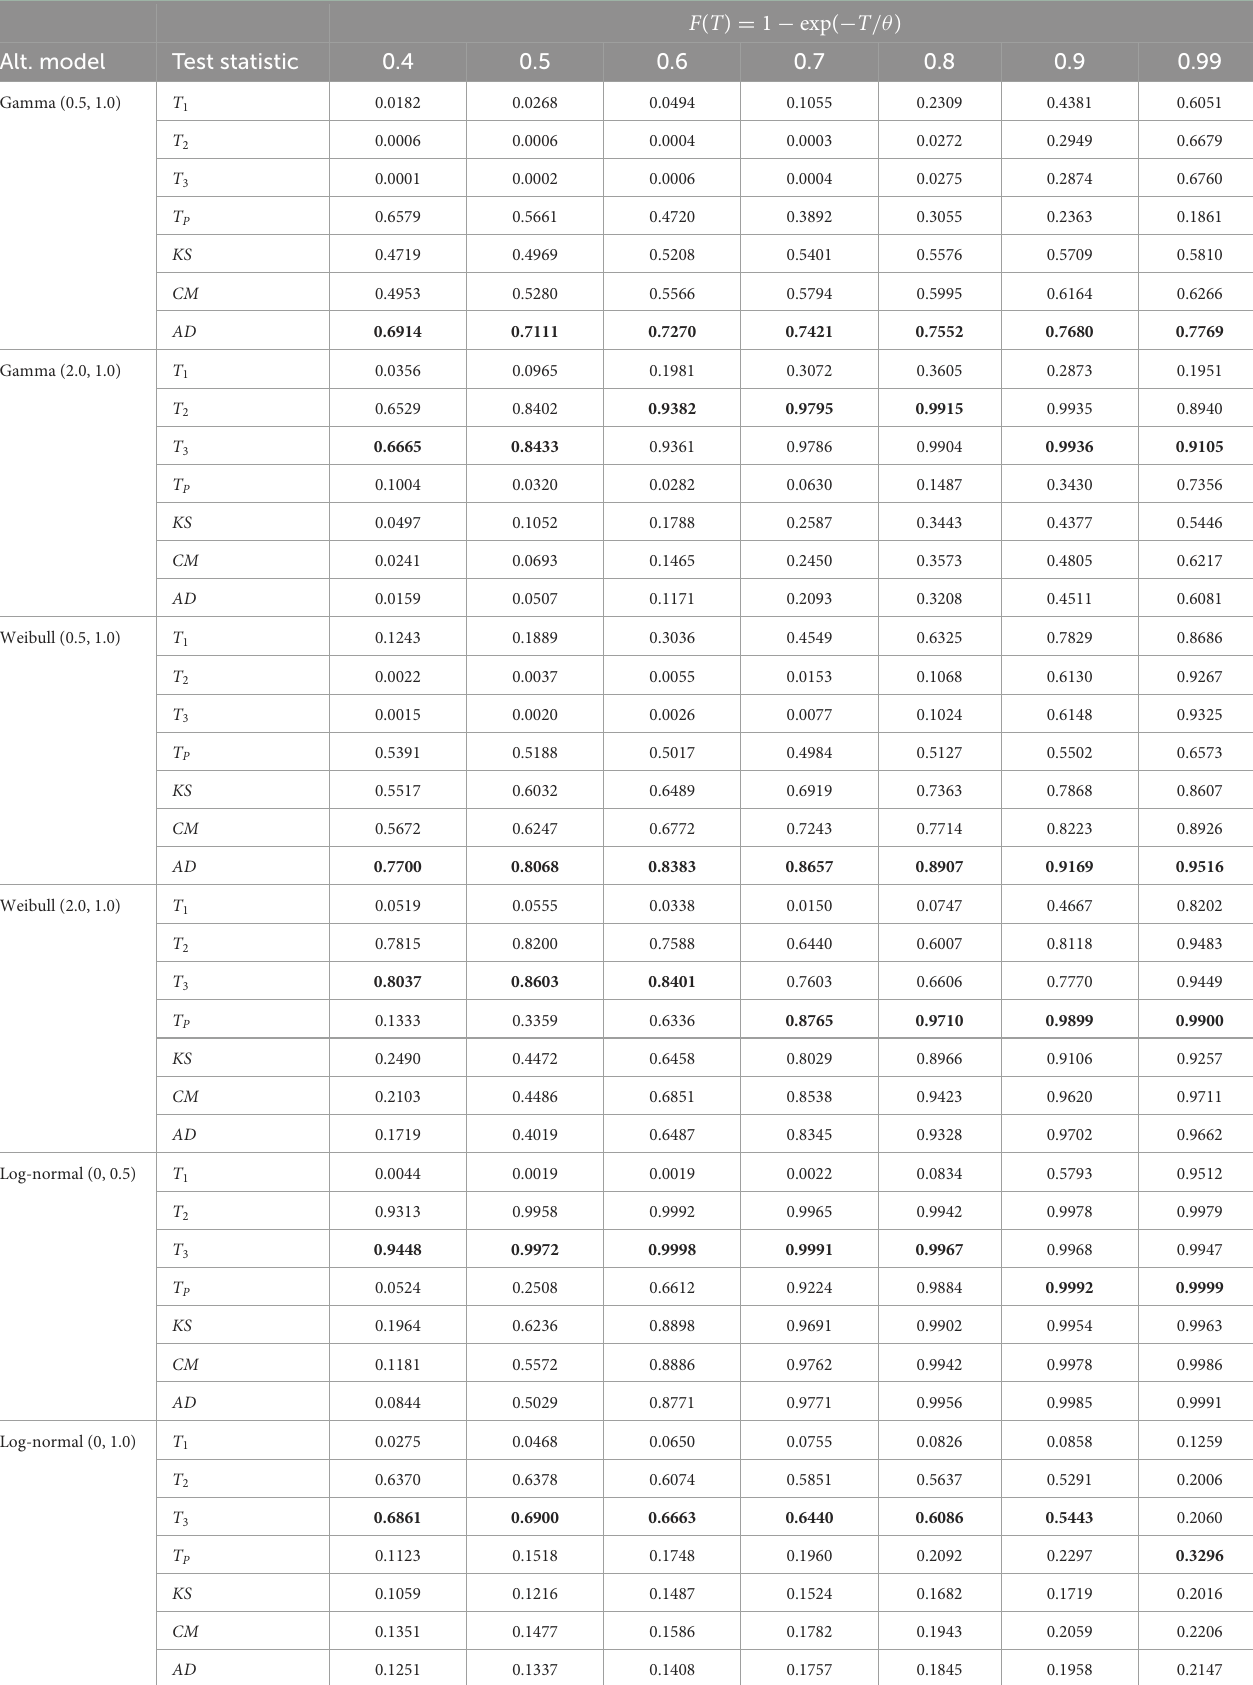
20, α 0.10 and 10 5 = =